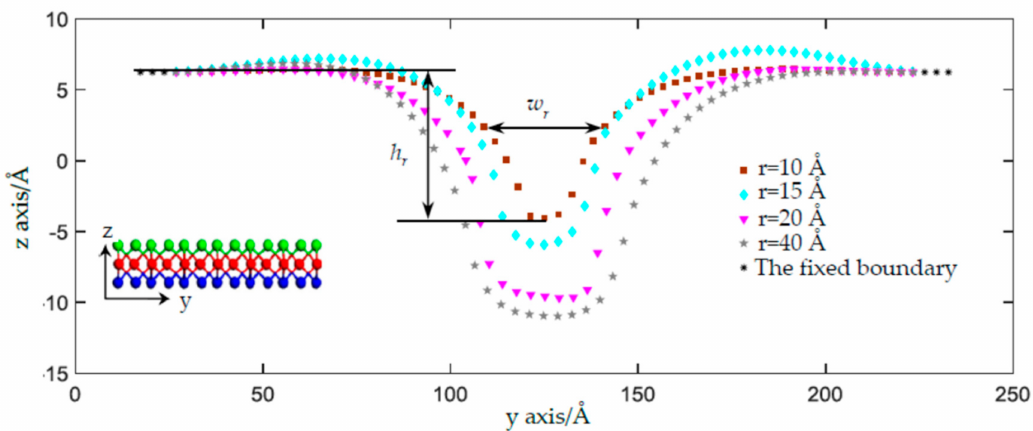
Figure 6. The sectional view of atoms in residual indentation with different indenter radii of 10 Å, 15 Å, 20 Å, and 40 Å at the deflection exceeding δ a after the unloading process. The rectangular, prismatic, triangular, and pentagonal points are the atomic positions of the Mo atoms close to the plane ( yz plane) crossing the center of the